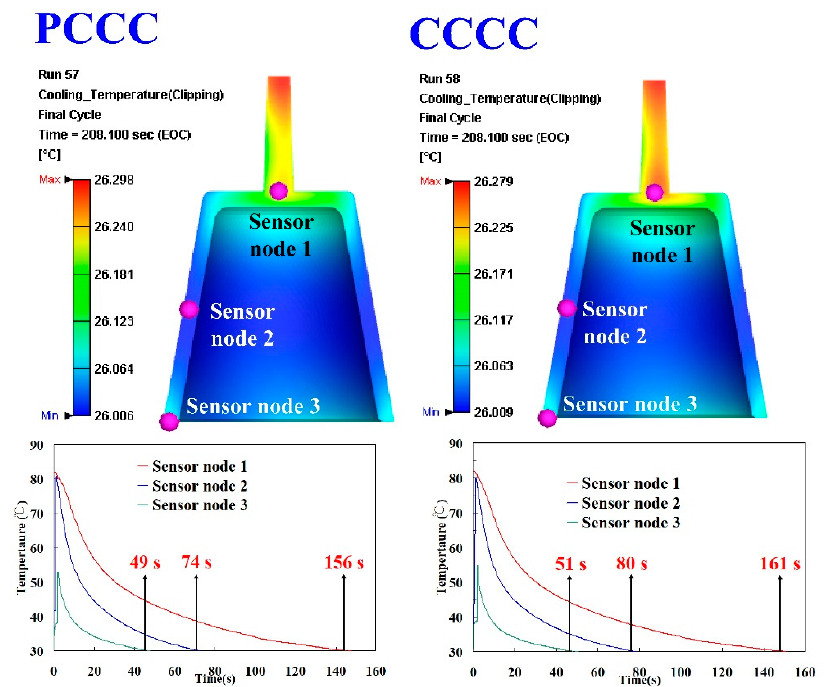
Figure 13. Simulation results of the cooling time of the injection-molded part for the injection mold fabricated by epoxy resin added with 39 vol.% Al powder.